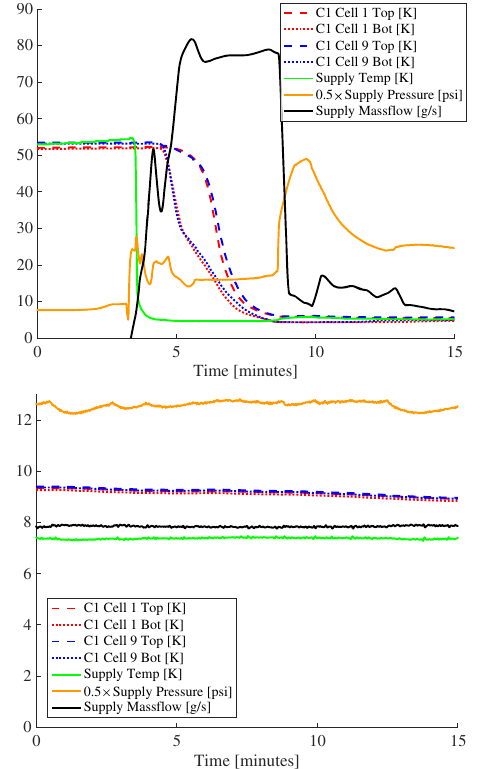
FIG. 2. High (top) and low (bottom) mass flow cooldowns of the Fermilab LCLS-II prototype cryomodule. When 80 g = s mass flow is achieved during cooldown through T c , the temperature difference from the top to the bottom of the cavity is several kelvin, but the difference is much less than 1 K for the 8 g = s cooldown.